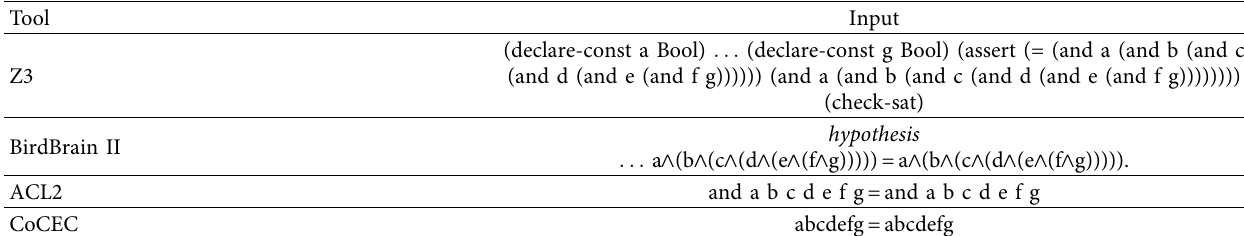
Table 1: Input comparison of CoCEC with other formal tools.